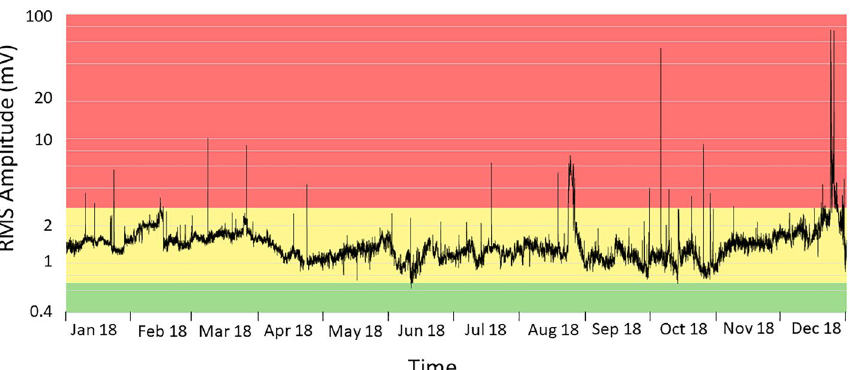
Figure 2. RMS amplitude of volcanic tremor at the ESLN station in 2018. The station is equipped with a velocimeter. The data are filtered between 0.5 and 2.5 Hz, and averaged over 30 min. The tremor amplitudes remained at an intermediate level, marked by the yellow band, concurrent with low to moderate Strombolian activity more or less throughout the